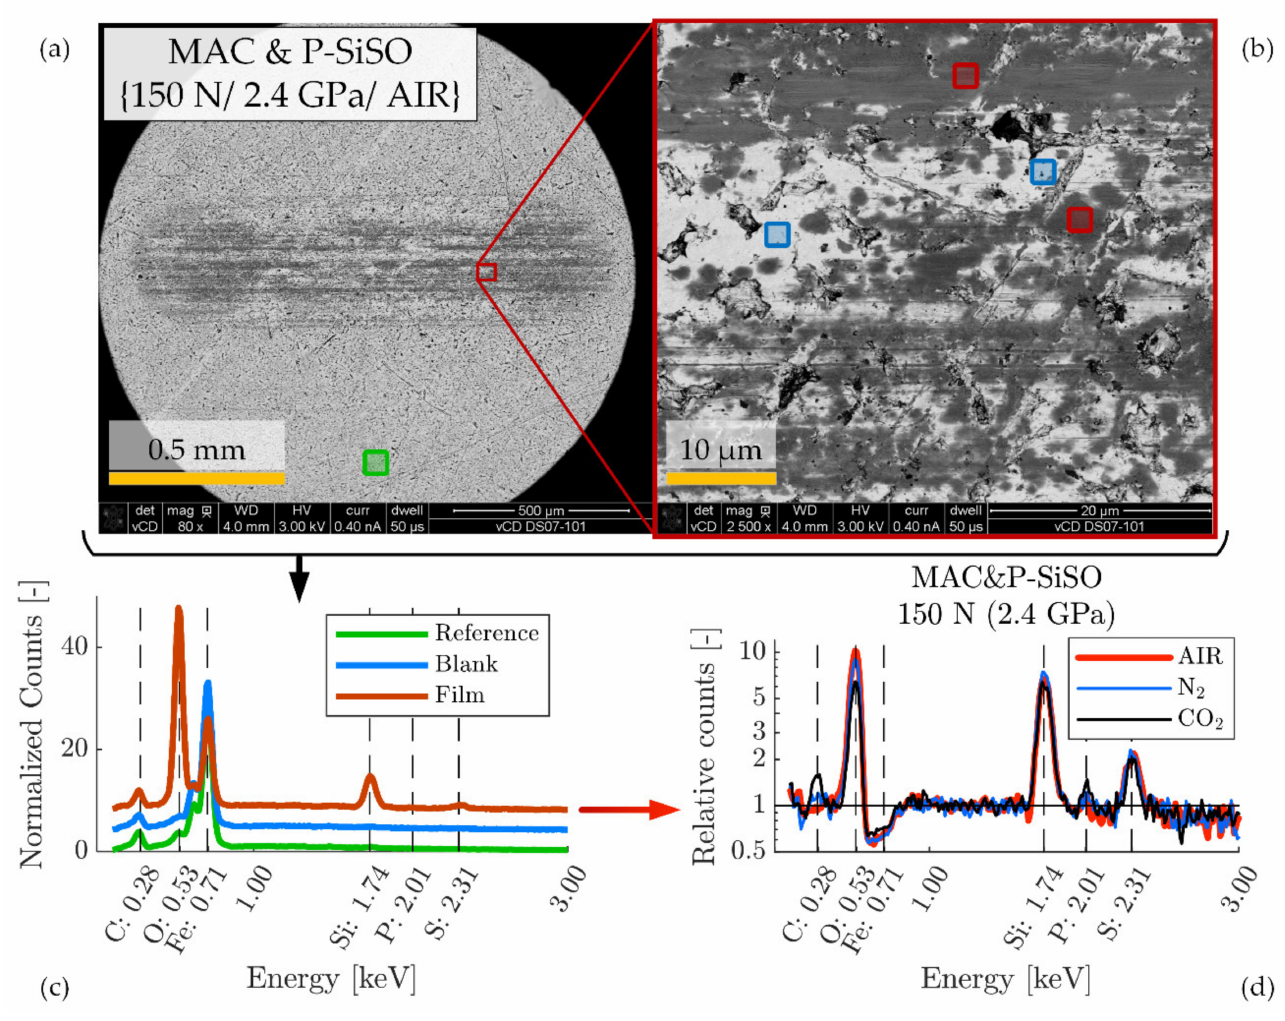
Figure 9. SEM-EDS analysis of SRV-3 steel disc sample lubricated with neat ‘MAC &P-SiSO’ under conditions {150 N/2.4 GPa/AIR}. ( a ) Low magnification SEM image of wear scar with locations of analyzed region and unworn reference. ( b ) High magnification SEM image showing wear scar region analyzed by EDS. ( c ) EDS spectra for unworn region (reference), boundary film region (Film), and worn region without visible film (Blank). ( d ) Relative counts (in relation to reference) in log-scale shows detected X-ray photons over the energy spectra covering the elements of interest in the boundary films that were produced under conditions {150 N/2.4 GPa/AIR}, {150 N/2.4 GPa/N 2 }, {150 N/2.4 GPa/CO 2